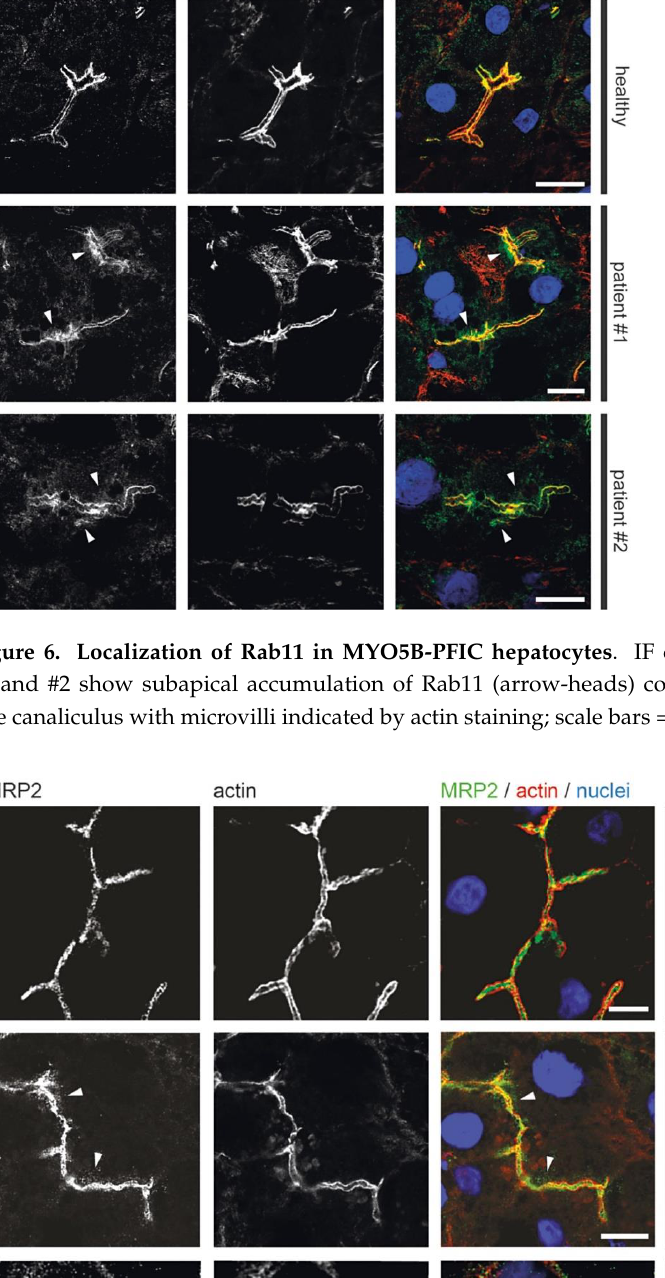
Figure 5. Localization of myo5b in MYO5B-PFIC hepatocytes. Laser-scanning immuno-fluores- cence micrographs (IF) of hepatocytes from patient #1 and #2 show regular localization of mutated myo5b to the apical plasma membrane compared to healthy controls. Bile canaliculus with micro- villi indicated by actin staining; scale bars = 5 µm.